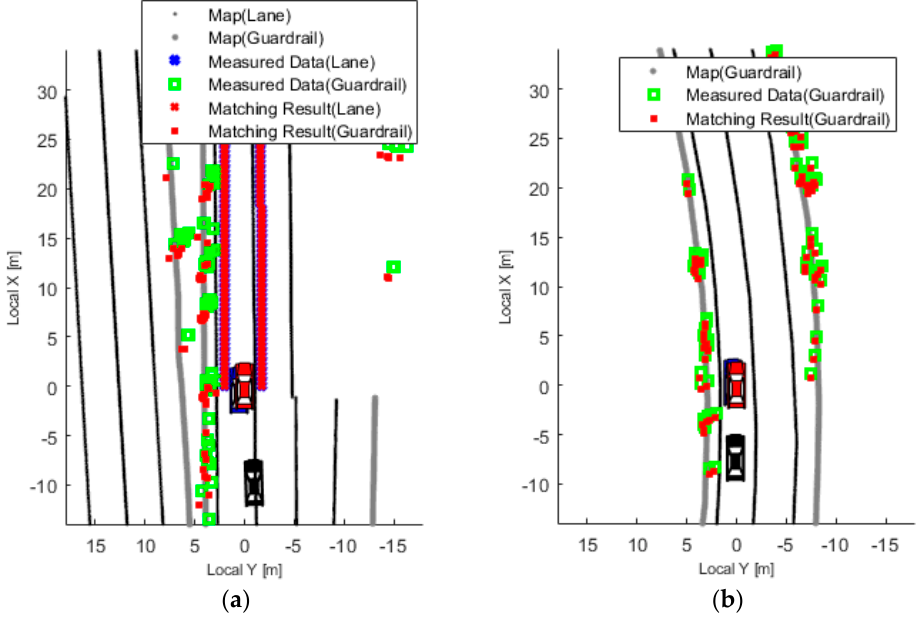
Figure 6. Algorithm verification scene (vehicle Color: red—localization result, black—Low-cost GPS, blue—DGPS (RT3002) for reference). ( a ) Lane + guardrail matching (junction (JC): entry). ( b ) Guardrail matching only (no lane; JC: middle).